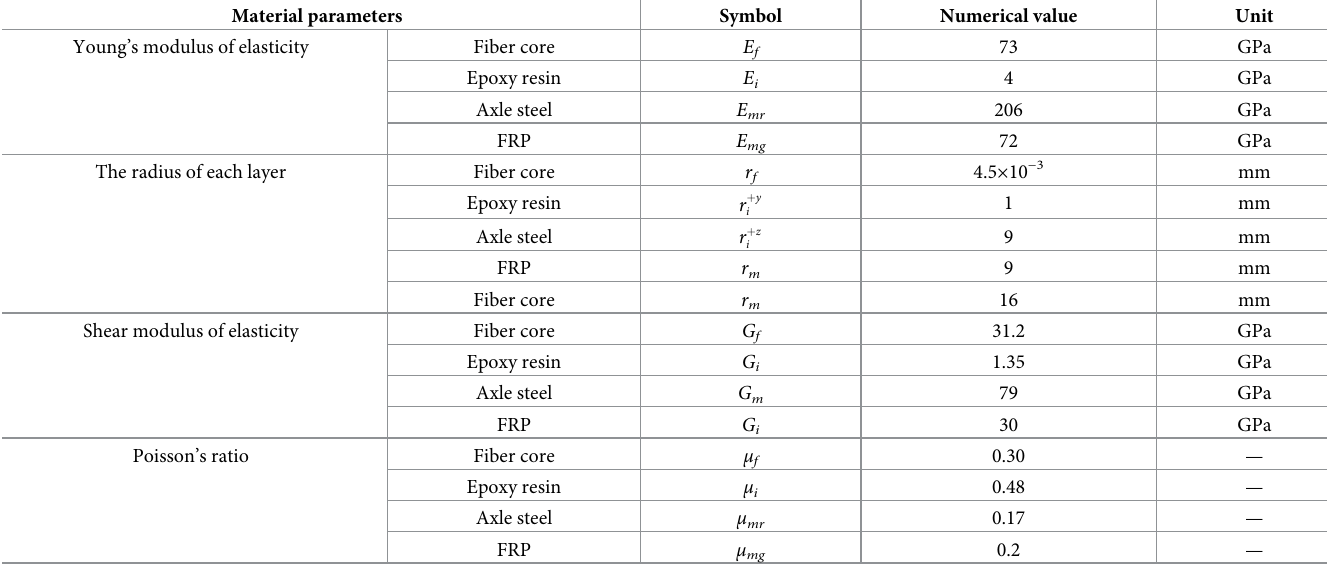
Table 1. Mechanical properties of the core, epoxy resin, and the base structure. Material